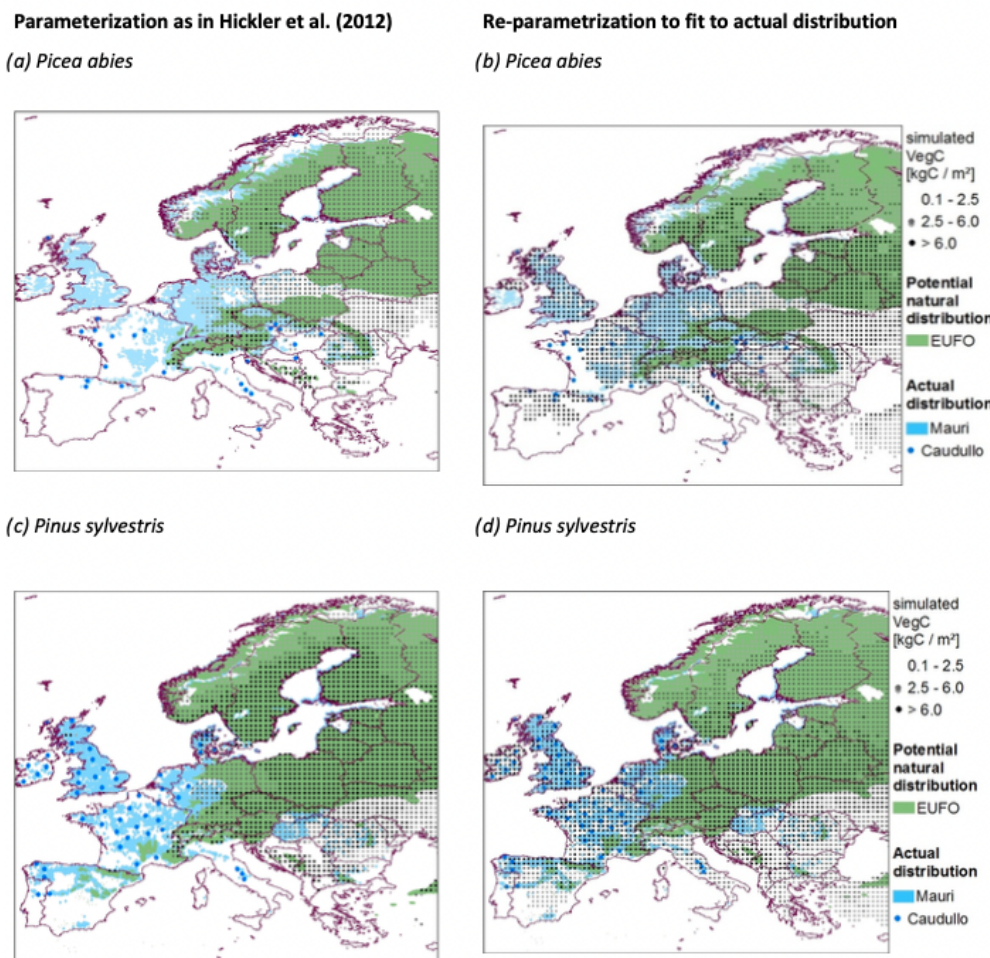
Figure A2. Simulated (black points), observed (blue), and natural distributions (green) of the adjusted parametrization (b, d) compared to applying the parametrization from Hickler et al. (2012) (a, c) for Picea abies and Pinus sylvestris . EUFO indicates data from EUFROGEN (2008 and 2013), Mauri indicates data from Mauri et al. (2017), and Caudullo indicates data from Caudullo (2017). The simulations were run from 1600 to 2010 without management and without competition between species. The plotted biomasses were averages over the last 20